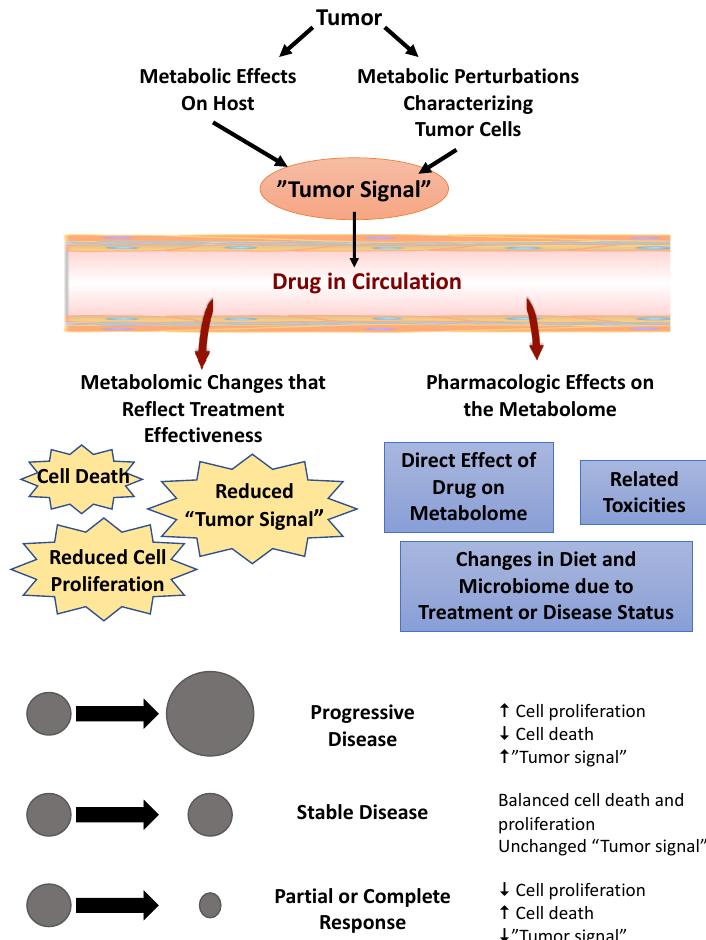
Figure 1. Causes of treatment-related changes in the circulating metabolome in individuals who have received antineoplastic agents. Pharmacologic effects are independent of therapeutic